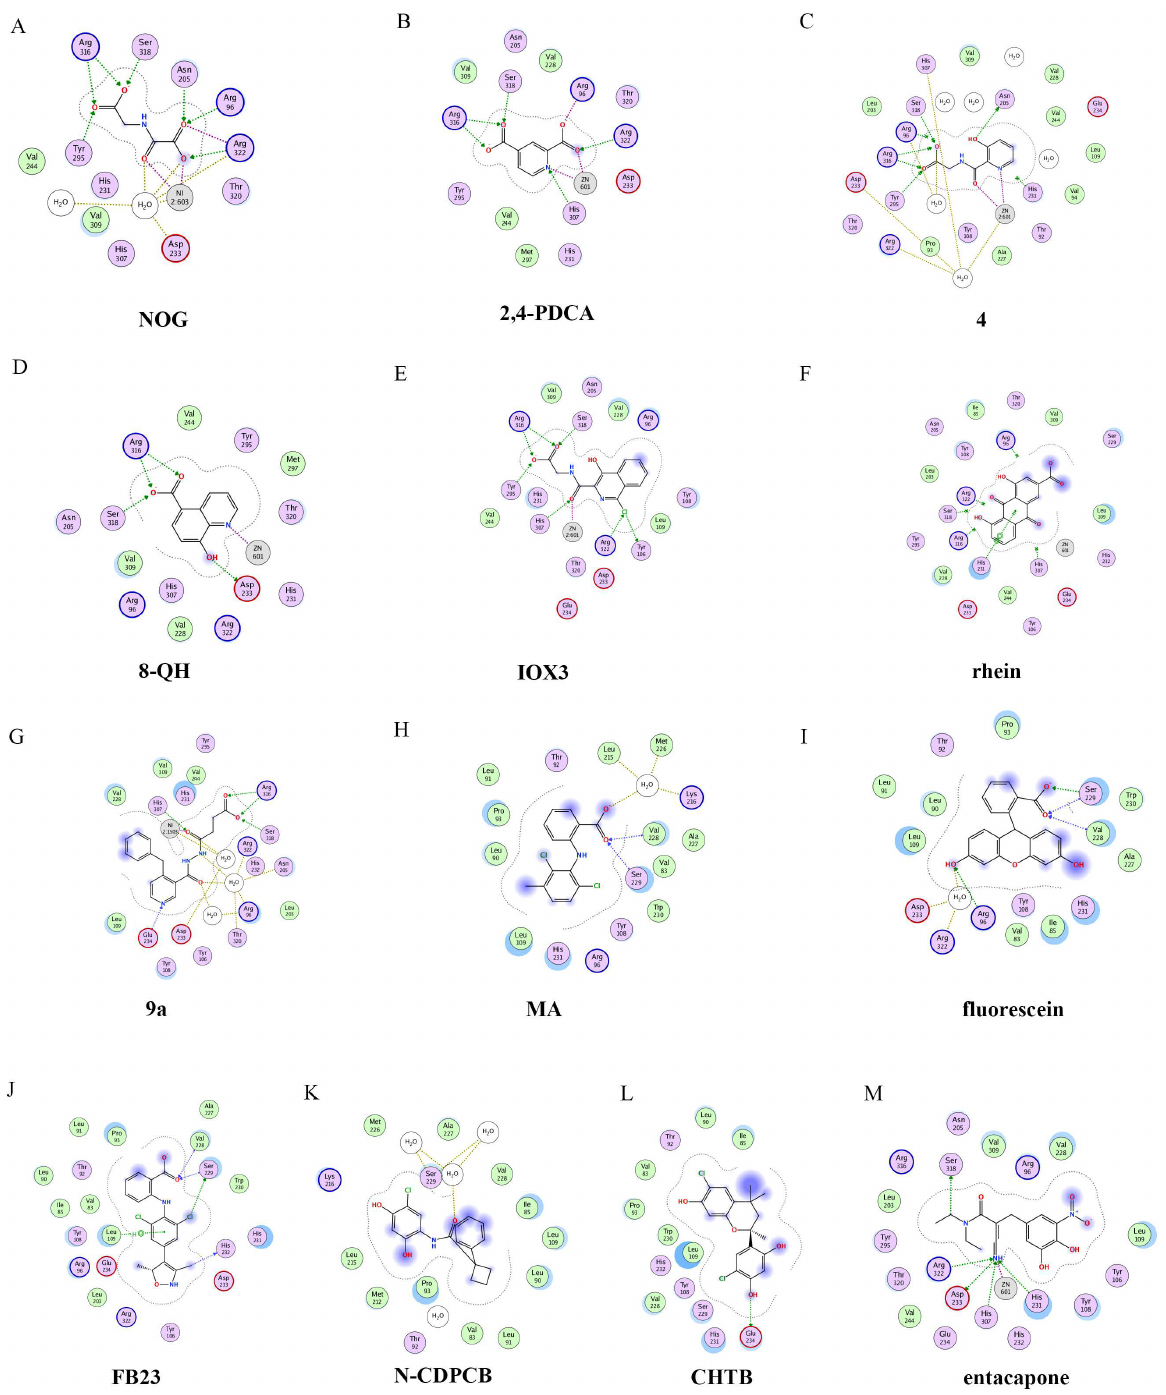
Figure 5. Two-dimensional representation of ligand–protein interactions of FTO inhibitors with FTO protein using MOE software. In MOE, the polar and non-polar residues are shown in pink and green disks; the water molecules are drawn as white circles; the metal ions are shown in grey circles; the hydrogen bonds are indicated by green dotted lines. ( A – M ) Ligand interactions of FTO with distinct compounds: ( A ) NOG (PDB ID: 4IDZ); ( B ) pyridine-2,4-dicarboxylate (2,4-PDCA, PDB ID: 4IE0); ( C ) 4 (PDB ID: 4IE5); ( D ) 8-QH (PDB ID: 4IE4); ( E ) IOX3 (PDB ID: 4IE6); ( F ) rhein (PDB ID: 4IE7); ( G ) 9a (PDB ID: 4CXW); ( H ) Meclofenamic acid (MA ) (PDB ID: 4QKN); ( I ) fluorescein (PDB ID: 4ZS2); ( J ) FB23 (PDB ID: 6AKW); ( K ) N-CDPCB (PDB ID: 5DAB); ( L ) CHTB (PDB ID: 5F8P); and ( M ) entacapone (PDB ID: